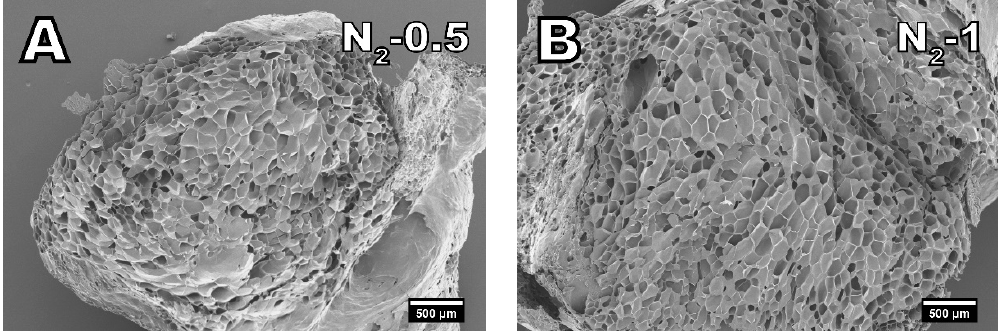
Figure 4. SEM images of samples foamed with carbon dioxide in amounts of ( A ) 0.5%, ( B ) 1%, and ( C ) 3%. (25 × magnification).